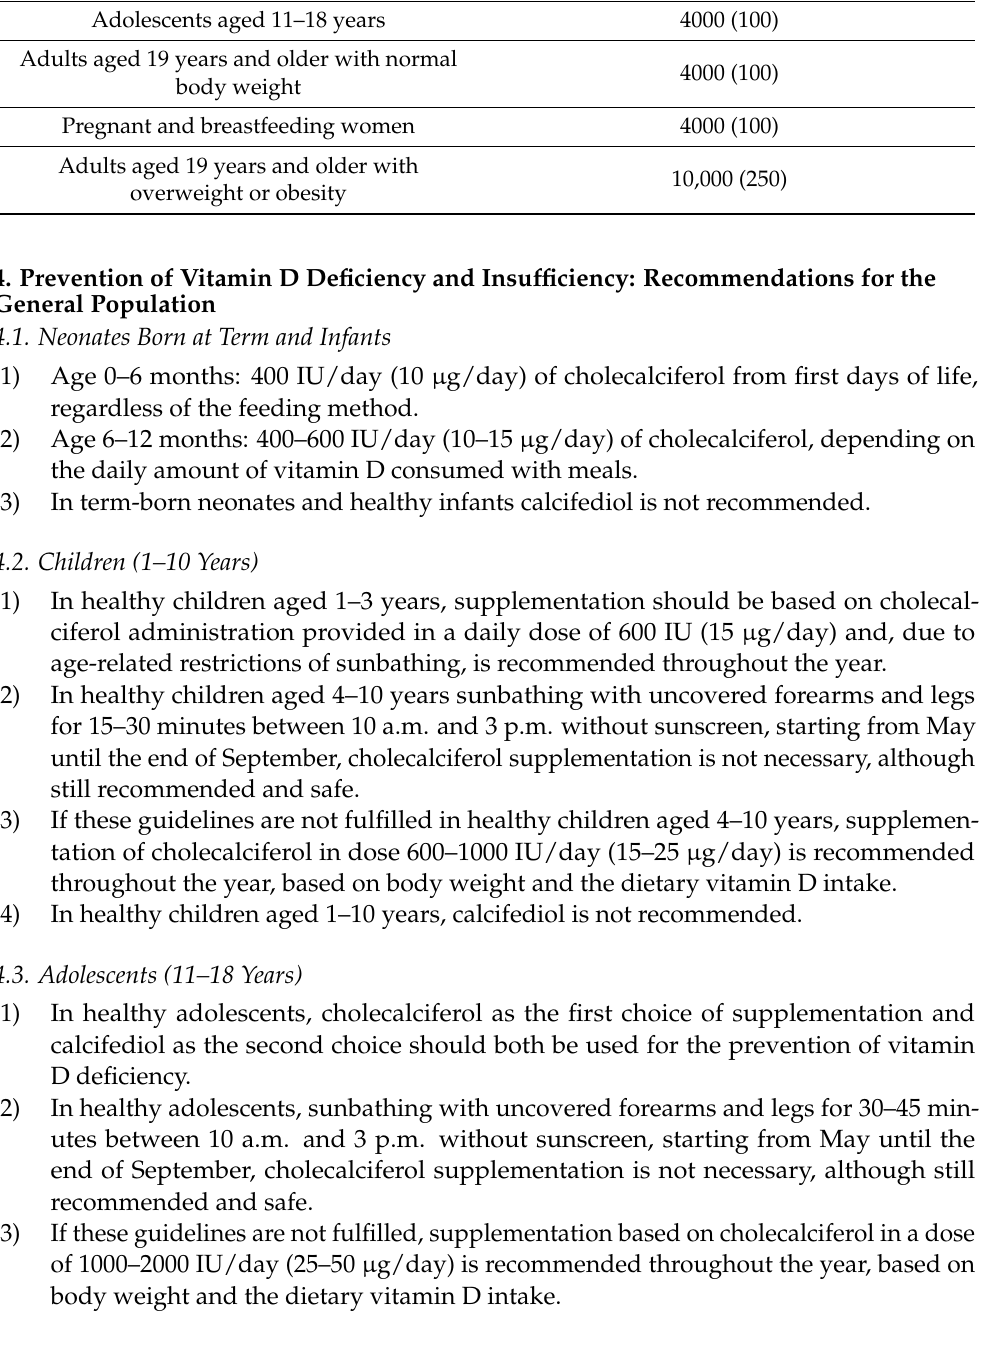
Table 2. Upper limits for daily cholecalciferol intake for vitamin D deficiency prophylaxis in the general population by age. Tolerable Upper Intake Level, IU/day Age ( µ g/day) Neonates and infants aged 0–12 months 1000 (25) Children aged 1–10 years 2000 (50) Adolescents aged 11–18 years 4000 (100) 4000 (100) body weight Pregnant and breastfeeding women 4000 (100) overweight or